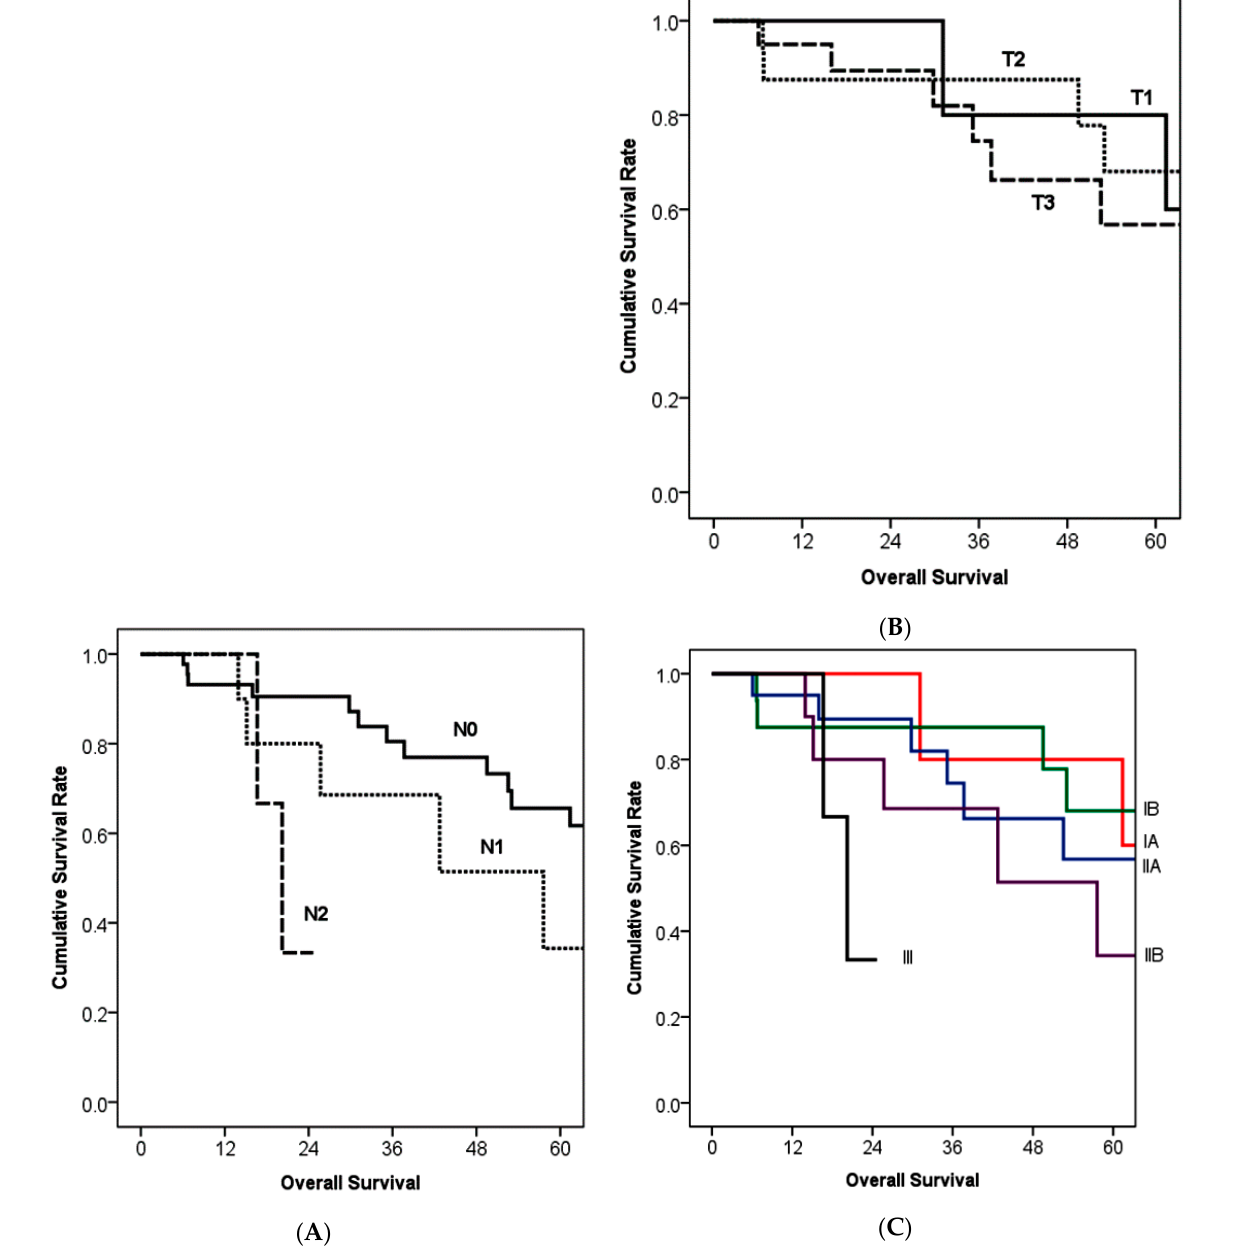
Figure 2. Kaplan–Meier survival curves according to the American Joint Committee on Cancer staging [14]. ( A ) When the analysis considered N stage ( n = 59), there was a significant difference between N0 and N2 ( p = 0.011), although there was no significant difference in comparison of N0 vs. N1 ( p = 0.246) or N1 vs. N2 ( p = 0.219). The median survival was 96.3 months in N0, 57.6 months in N1, and 20.2 months in N2. ( B ) When the analysis considered T stage in N0 patients ( n = 44), there was no significant difference between T stages ( p = 0.604 for T1 vs. T2, p = 0.263 for T2 vs. T3, and p = 0.729 for T1 vs. T3). The median survival was 77.5 months in T1, not reached in T2, and 78.8 months in T3. ( C ) The median survival was 77.4 months in stage IA, not reached in stage IB, 78.8 months in stage IIA, 57.6 months in stage IIB, and 20.2 months in stage III. Stage III showed significant differences with other stages ( p = 0.21 for IA vs. III and p = 0.39 for IIA vs. III). In terms of adjuvant therapy, the kind of therapeutic modality did not show signifi- cant survival differences (Figure 3A). Although gemcitabine (GEM)-based chemotherapy